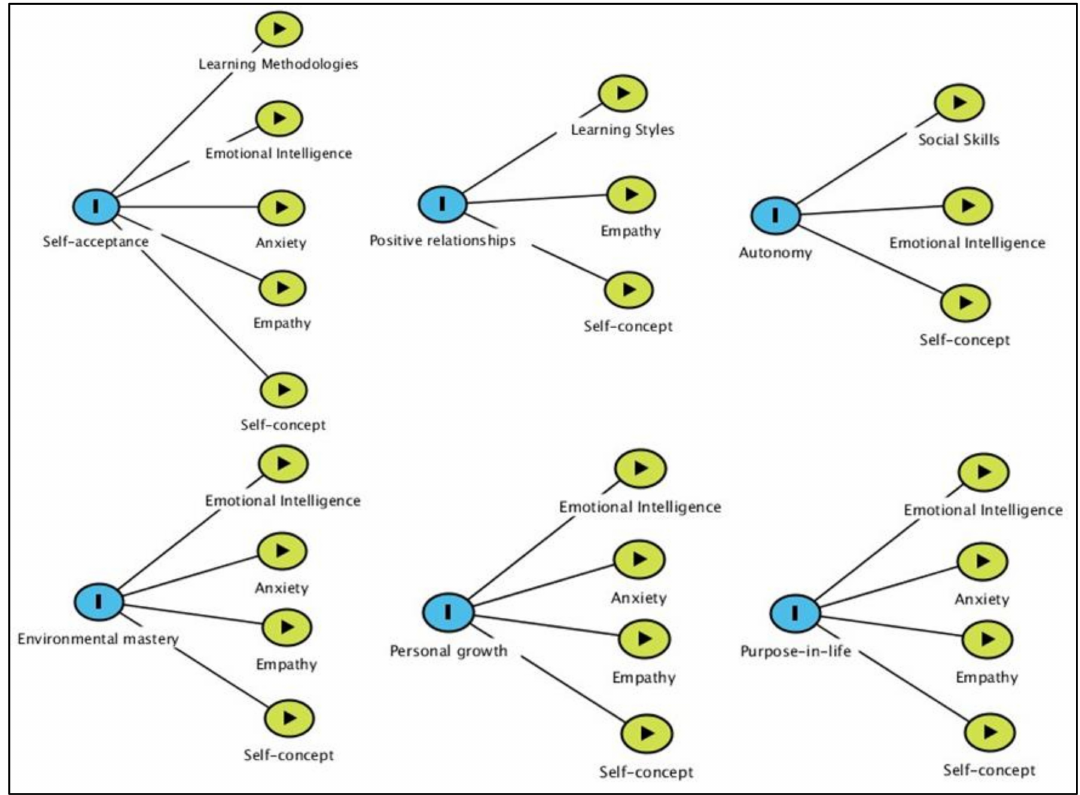
Figure 1. Directed acyclic graph of the relationship between the psychological well-being dimensions and psychosocial factors. Source: created with